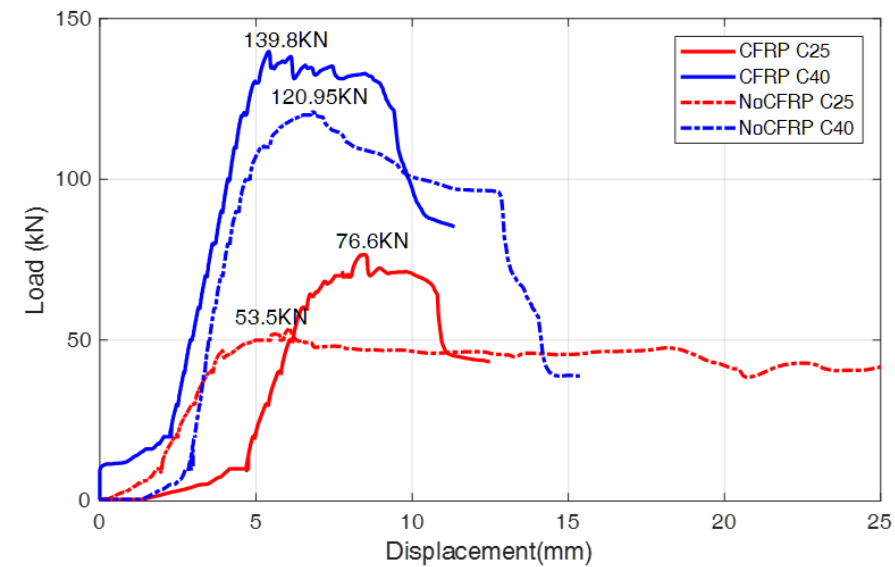
Figure 22. Load ‐ displacement curves under different test conditions. Figure 22. Load-displacement curves under different test